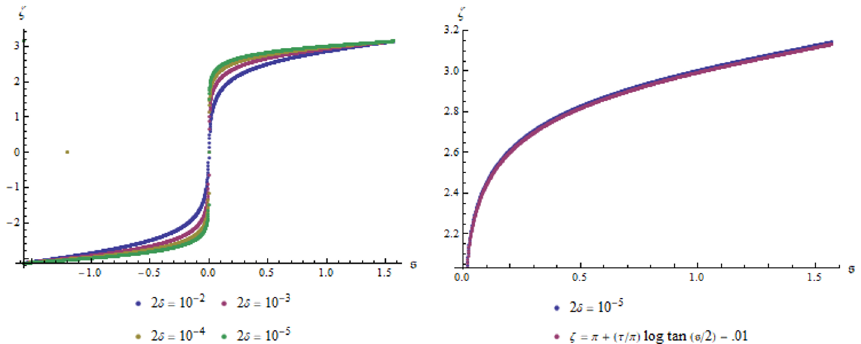
Figure 11. How the s ∈ R circle maps to the ζ ∈ R circle in the map (5.5). Left: we see that most of the s circle gets compressed to a small angular width in ζ , and that the concentration increases as δ → 0 . This plot uses a different range for s , ζ compared to the rest of the paper, to better show the concentration. Right: comparison of the numerical map and the analytic approximation (5.22) using parameter values from (5.8). The approximation has been offset so that both graphs are